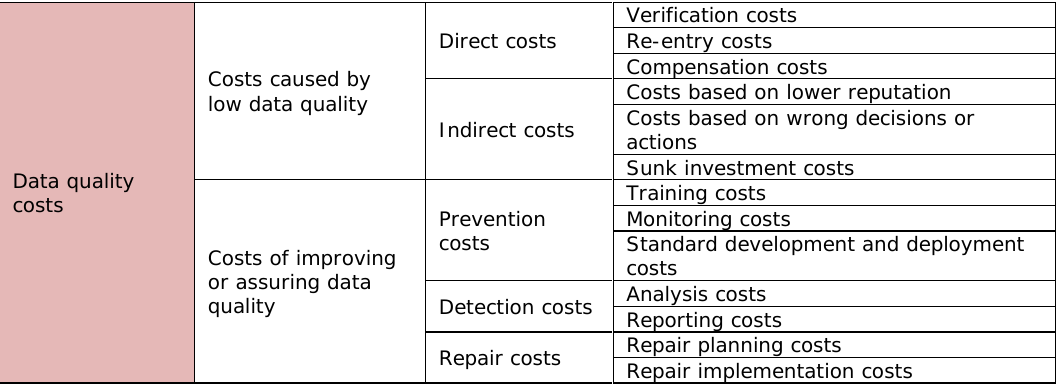
Table 3. “A data quality cost taxonomy”. Source: Eppler and Helfert